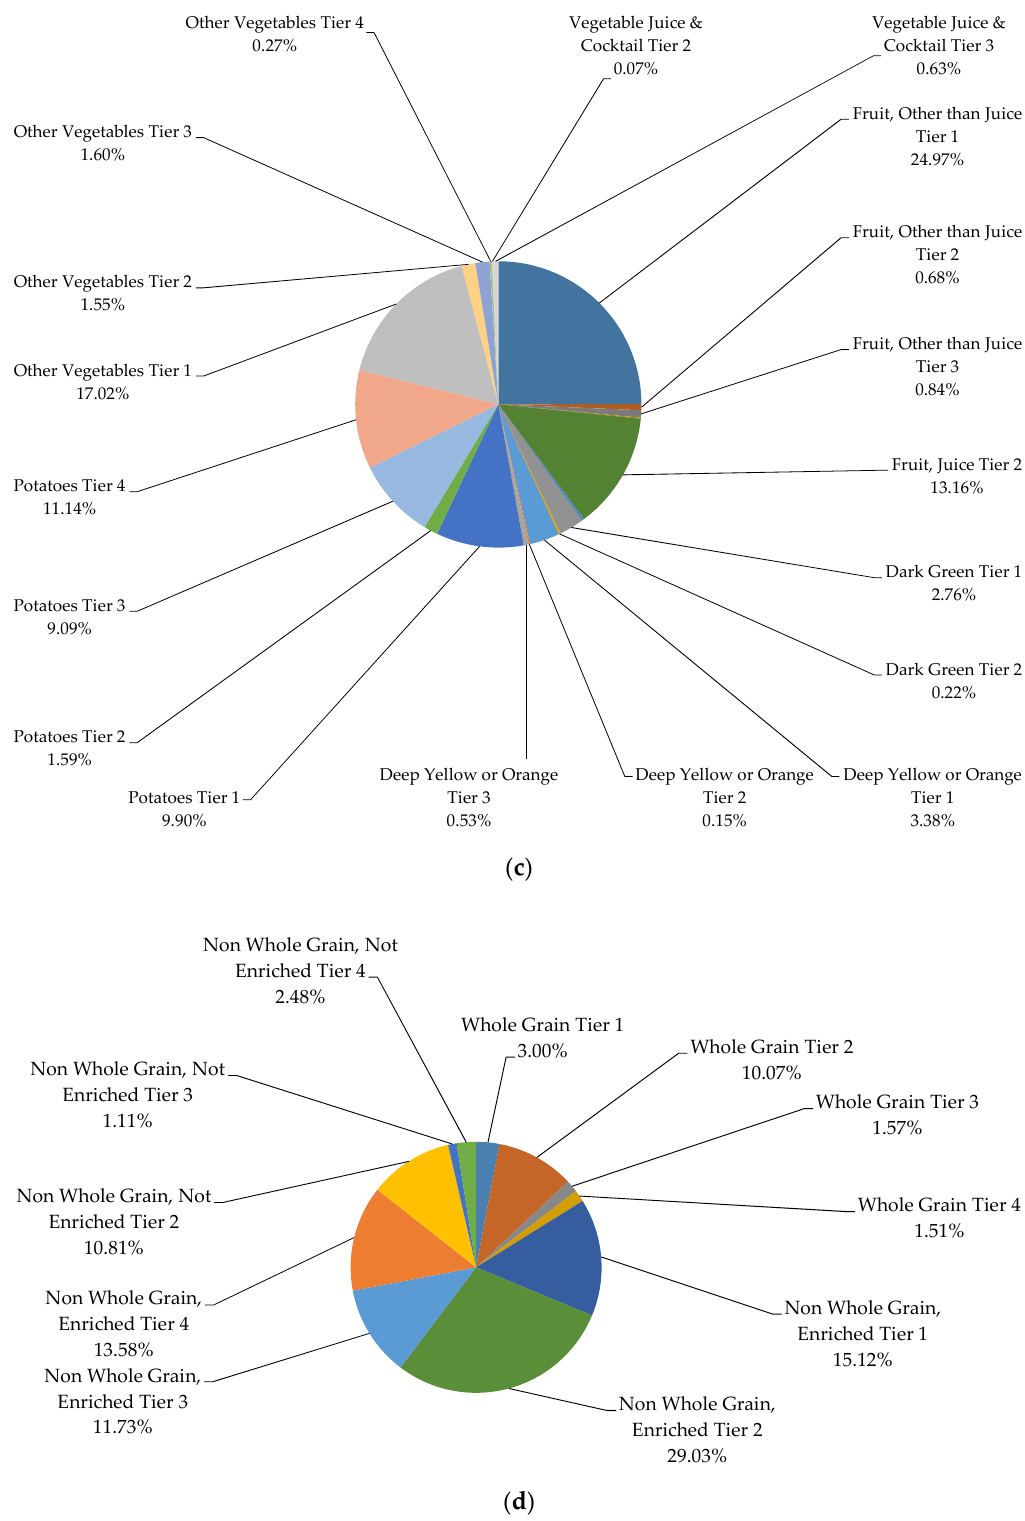
Figure 2. Cont. Figure 2.